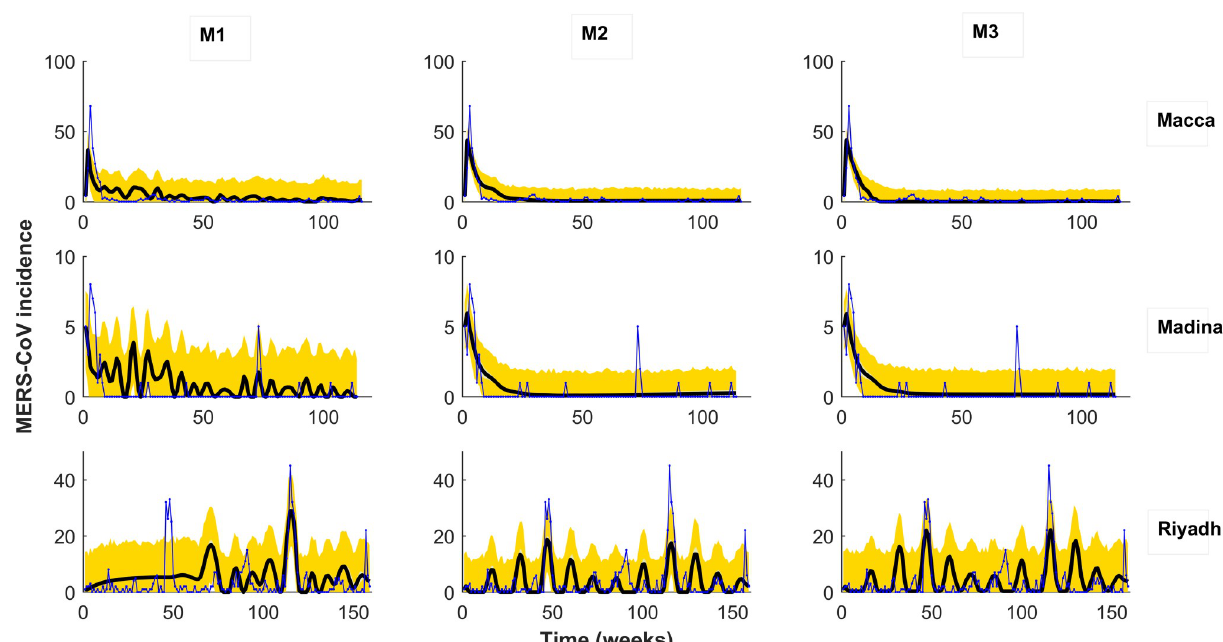
Fig 7. Single-strain model fitting to new MERS-CoV cases. Here M1: single strain model with BL force of infection, M2: single strain model with non- monotone incidence, and M3: single strain model with saturated incidence. Solid black curve represents model solution and yellow region denotes 95% confidence interval for predictions.